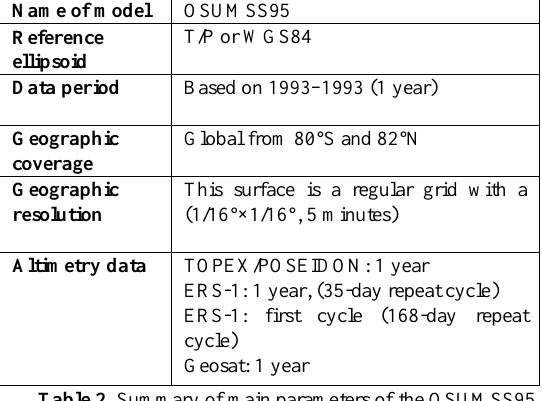
Table 2 . Summary of main parameters of the OSUMSS95 model.